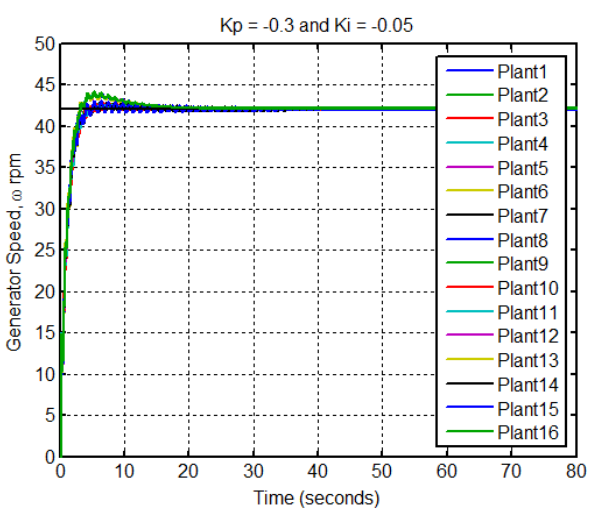
Figure 14. The step response for all 16 Kharitonov plants with Kp(-0.3) and